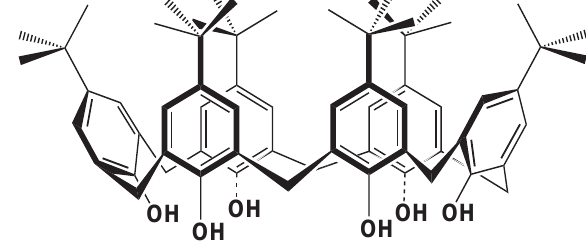
Figure 1. tert -Butylcalix[6]arene, comprising 6 CH -bridged phenyl rings. The conformation, 2 where substituents at the phenyl rings show into the same direction, is called